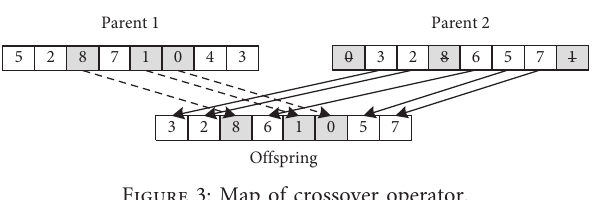
Figure 3: Map of crossover operator.